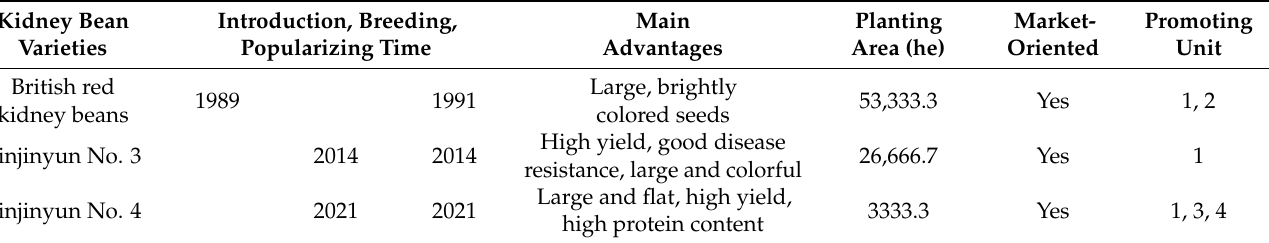
Table 3. Stages of the evolution of kidney bean